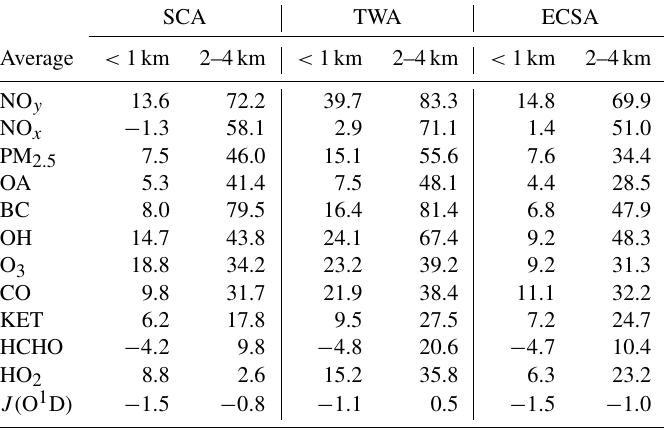
Table 4. Simulated biomass burning contribution (with and without BB emission in Indochina) in percentage (%) on 17 and 19 March 2018 for different regions: SCA, TWA, and ECSA as shown in Fig. 1a. SCA TWA ECSA Average < 1km 2–4km < 1km 2–4km NO